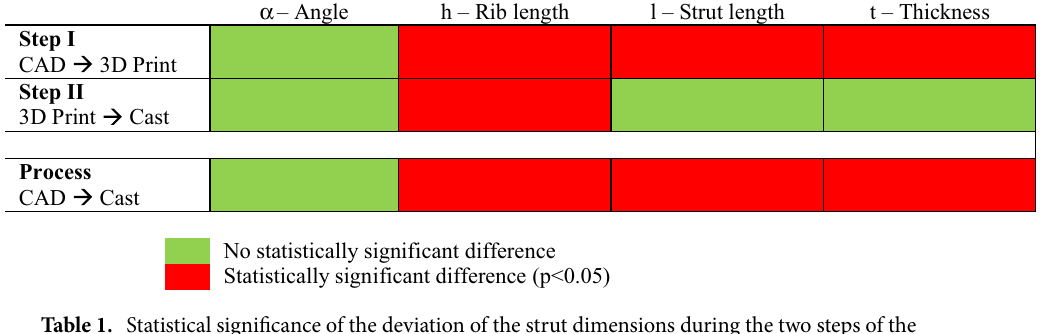
Table 1. Statistical significance of the deviation of the strut dimensions during the two steps of the manufacturing